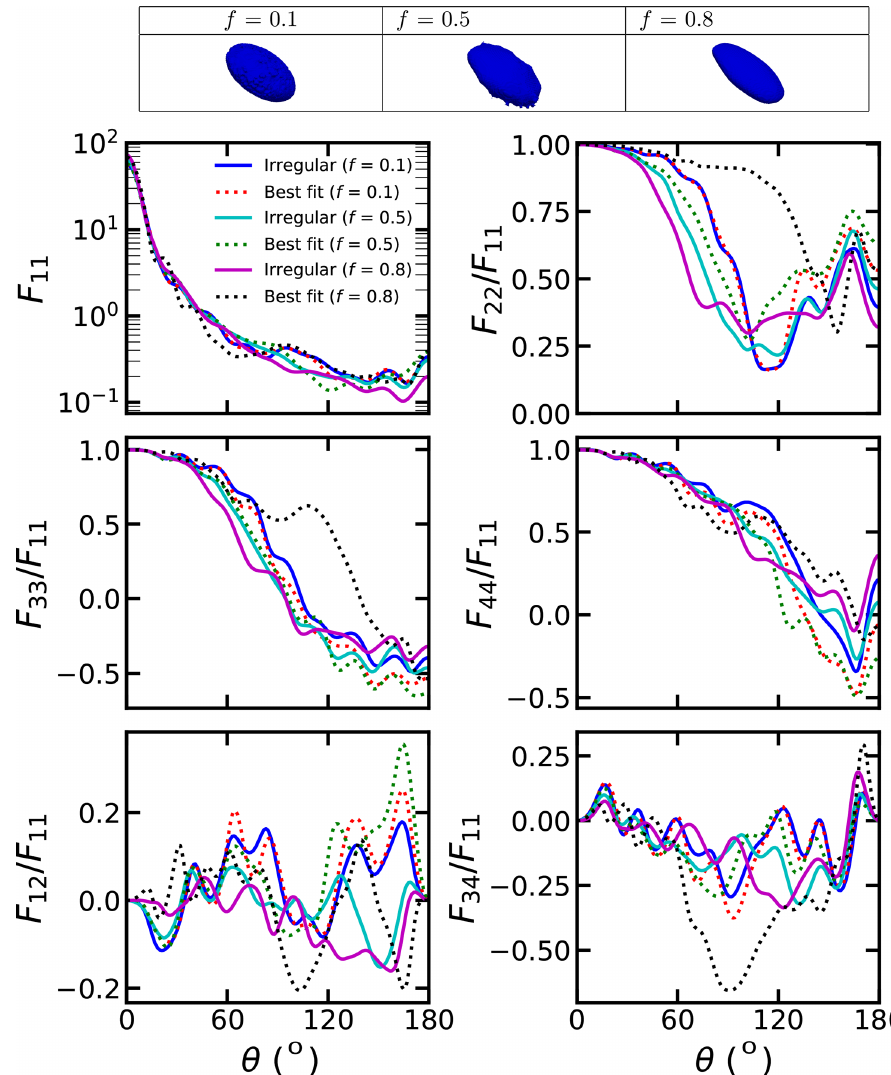
Figure 6. Similar to Fig. 4 but for an aspect ratio of 1 :